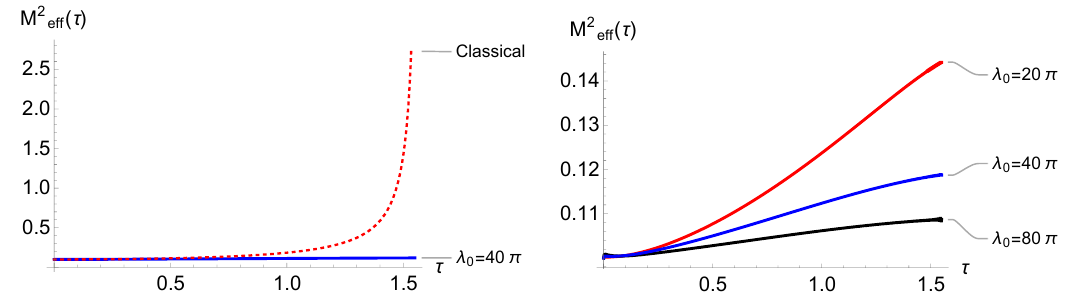
Figure 2 . Left : the evolution of M 2 ( (cid:28) ) for 0 < (cid:28) < (cid:25) in the interacting theory (solid blue) with e(cid:11) 2 (cid:21) 0 = 40 (cid:25) and (cid:21) 0 (cid:27) 0 = 0 : 2. For comparison we also show the classical (divergent) e(cid:11)ective mass on the same plot. Right : the evolution of e(cid:11)ective mass for three di(cid:11)erent choices of (cid:21) 0 with initial condition (cid:21) 0 (cid:27) 0 = 0 :